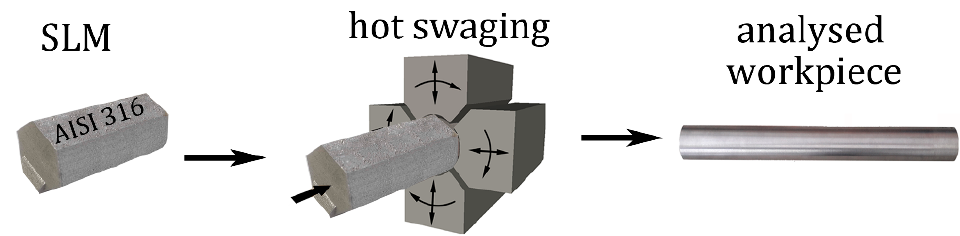
Figure 1. Schematic depiction of the experimental swaging